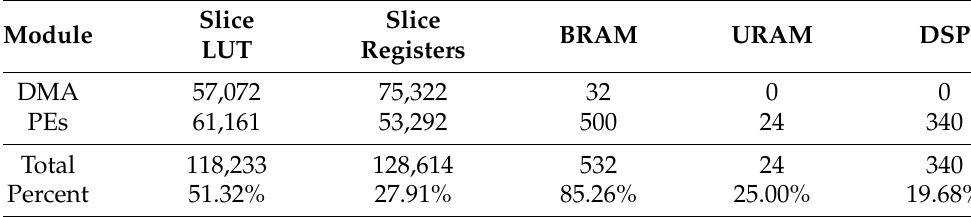
Table 8. Resource utilization of the